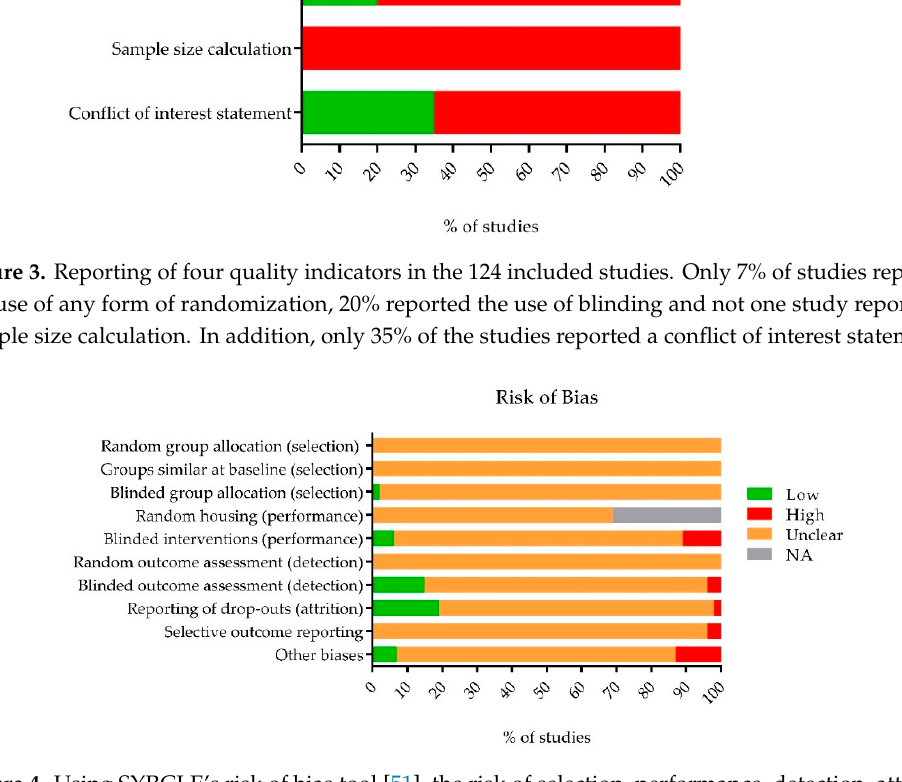
Figure 4. Using SYRCLE’s risk of bias tool [51], the risk of selection, performance, detection, attrition and other biases was assessed for the studies included in this review. The proportion of studies (%) which have a low, unclear or high risk of bias in several categories. As a consequence of poor reporting of measures to reduce several types of bias, the analysis resulted in a high percentage of “unclear” risk of bias for most items. NA (not applicable) holds true for studies that used an internal control in their experiments (e.g. one eye experimental group, other eye control group). Random housing between the experimental and control group is in that case, obviously, impossible.